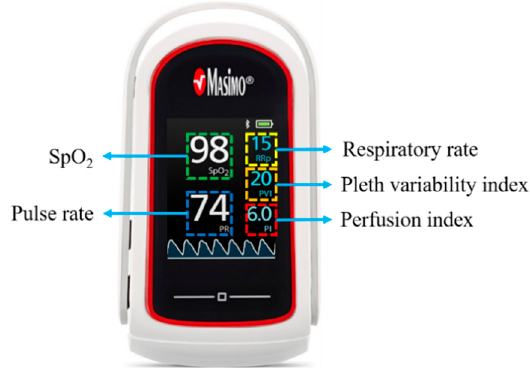
Figure 2. A commercial Masimo MightySat Rx Fingertip pulse oximeter (PO).